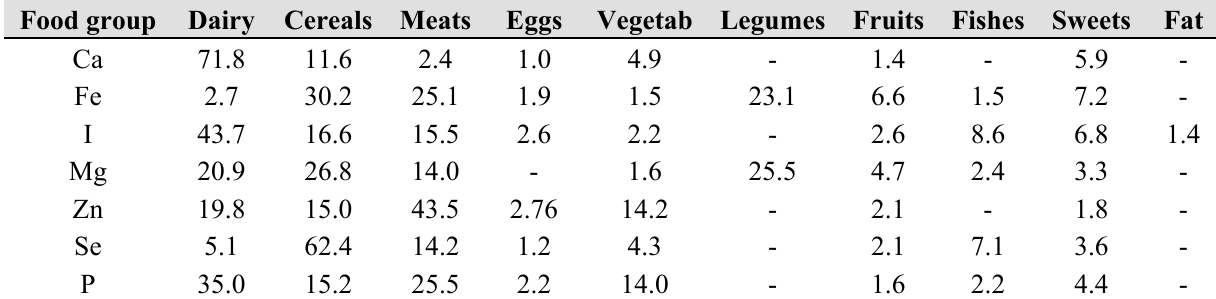
Table 5. Percentage contribution (%) of food groups to daily mineral intake.